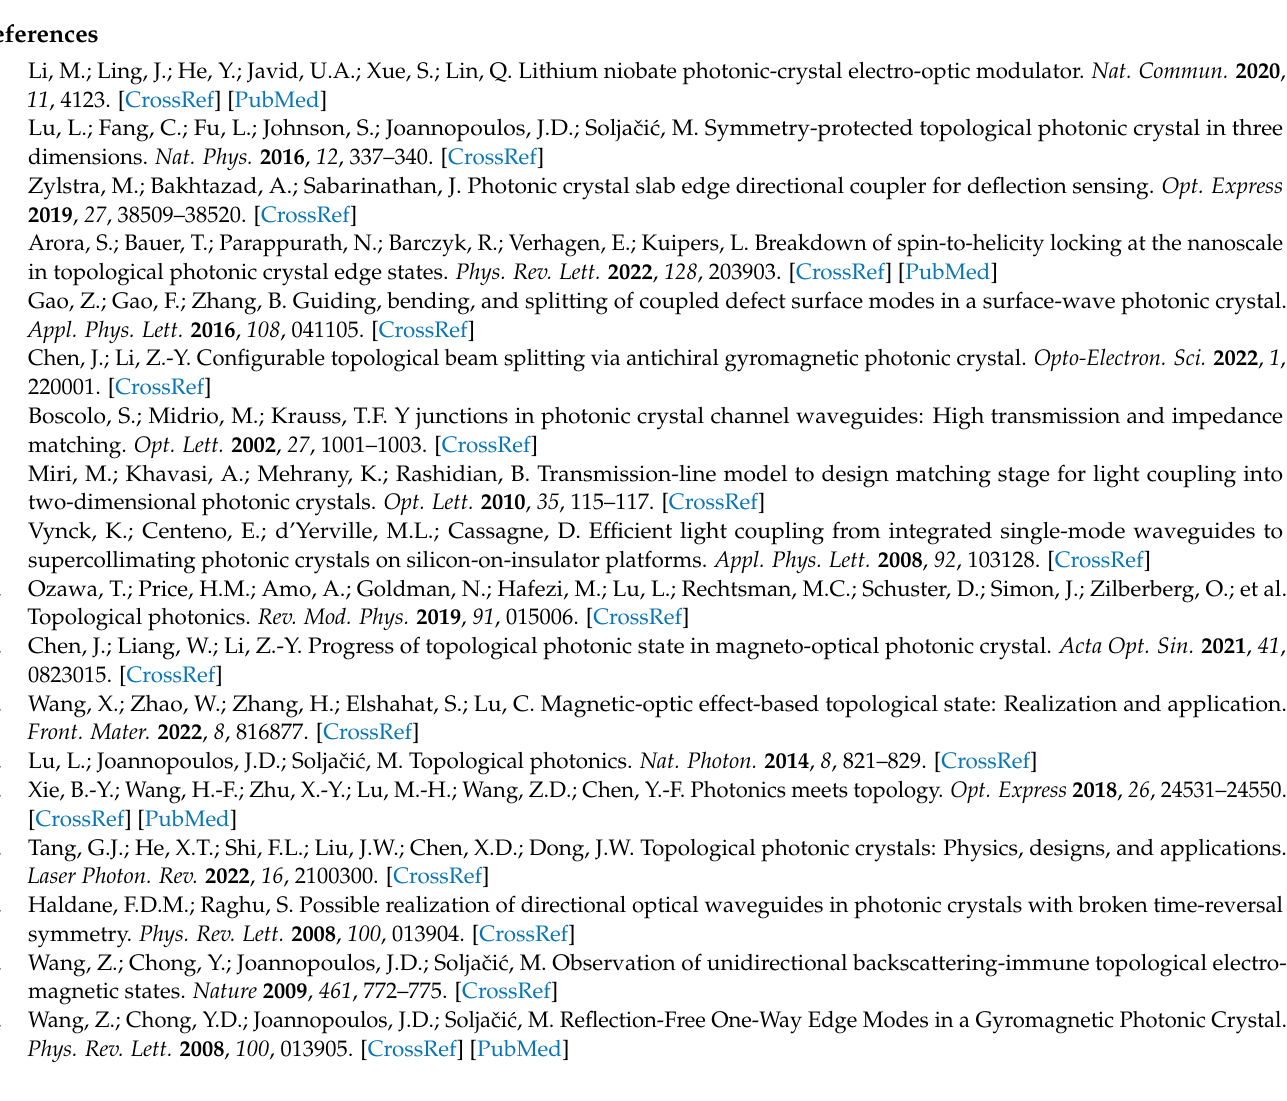
states of Edge 3. Figure S7: One-way edge states of Edge 4. Figure S8: One-way edge states of Edge 5. Figure S9: Transport robustness of one-way edge-states at five types of